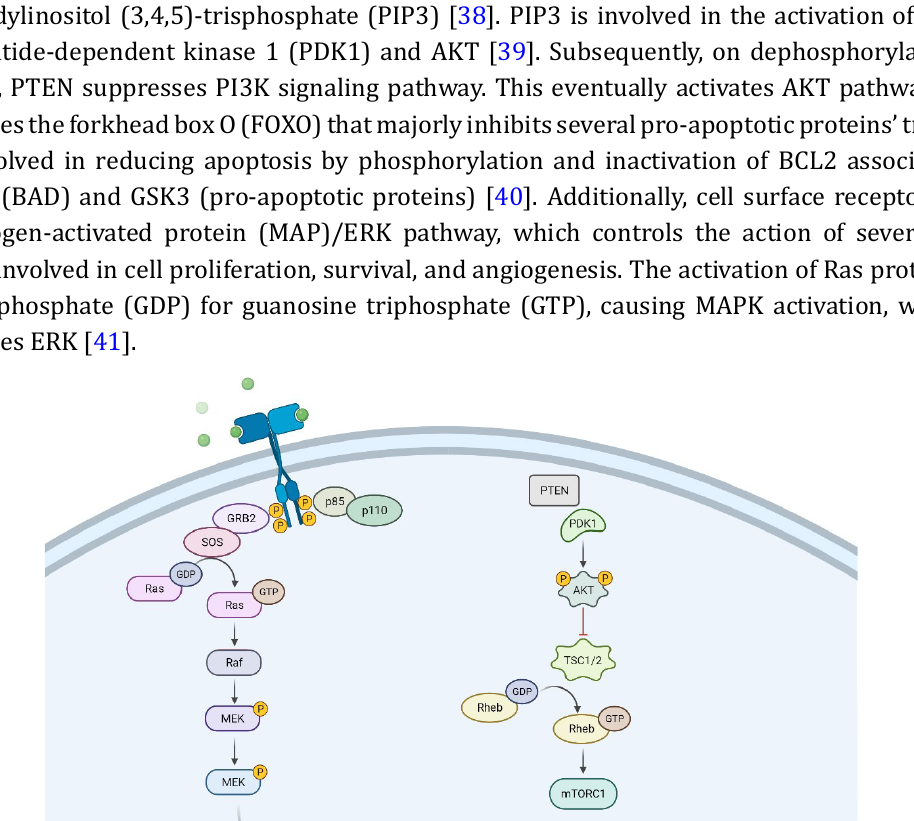
Explor Target Antitumor Ther. 2022;3:866–88 | https://doi.org/10.37349/etat.2022.00118